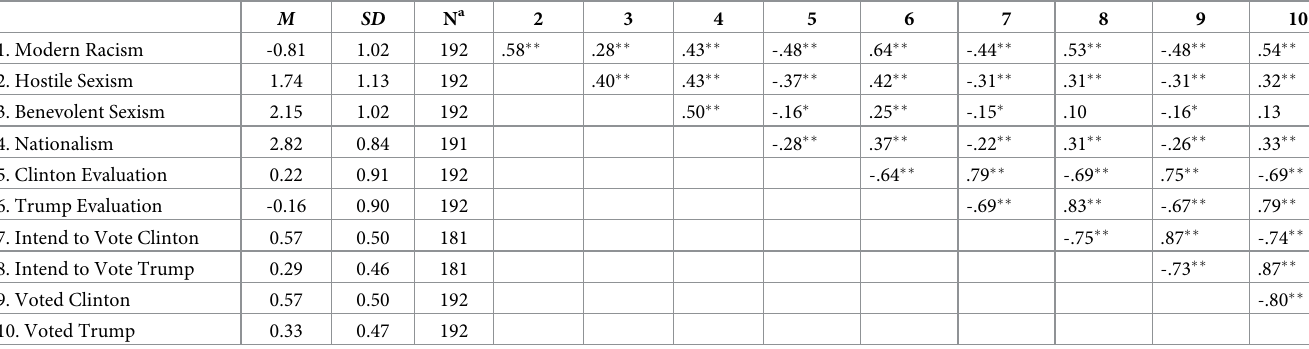
Table 5. Zero-order correlations among measures for participants who voted at Time